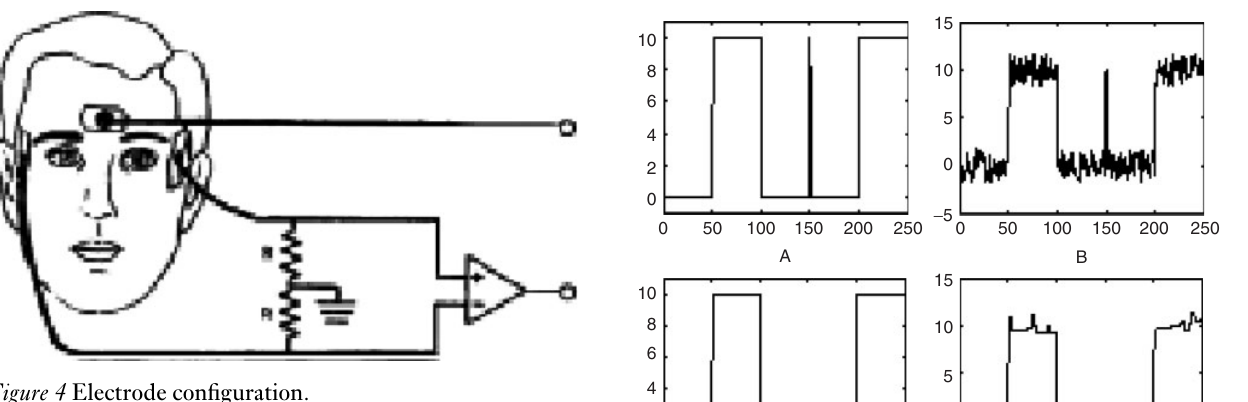
Figure 4 Electrode configuration.